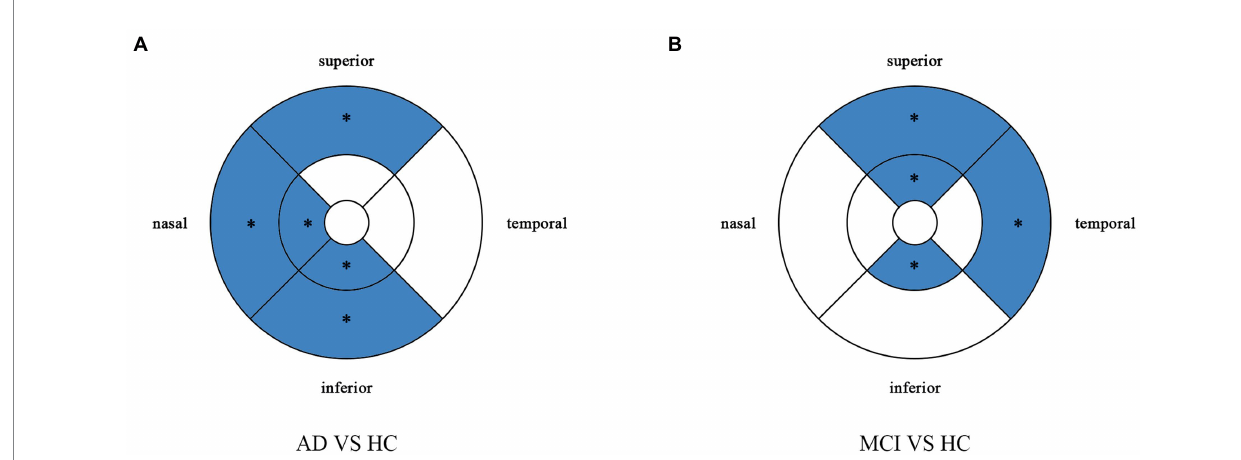
FIGURE 6 Multiple logistic regression was used to assess the association between retinal perfusion density and clinical diagnosis, adjusted for confounders of sex, age, history of alcohol intake, hypertension, hyperlipidemia, BCVA, and IOP. Blue regions indicate decreases significantly compared with the HC group. (A) Compared with HC group, perfusion density decreases significantly in the nasal and inferior regions of the inner ring and in the nasal, superior and inferior regions of the outer ring in the AD group. (B) Compared with HC group, perfusion density decreases significantly in the superior and inferior regions of the inner ring and in the temporal and superior regions of the outer ring in the MCI group. *Significant at p < 0.05. AD, Alzheimer’s disease; MCI, mental cognitive impairment; HC, healthy